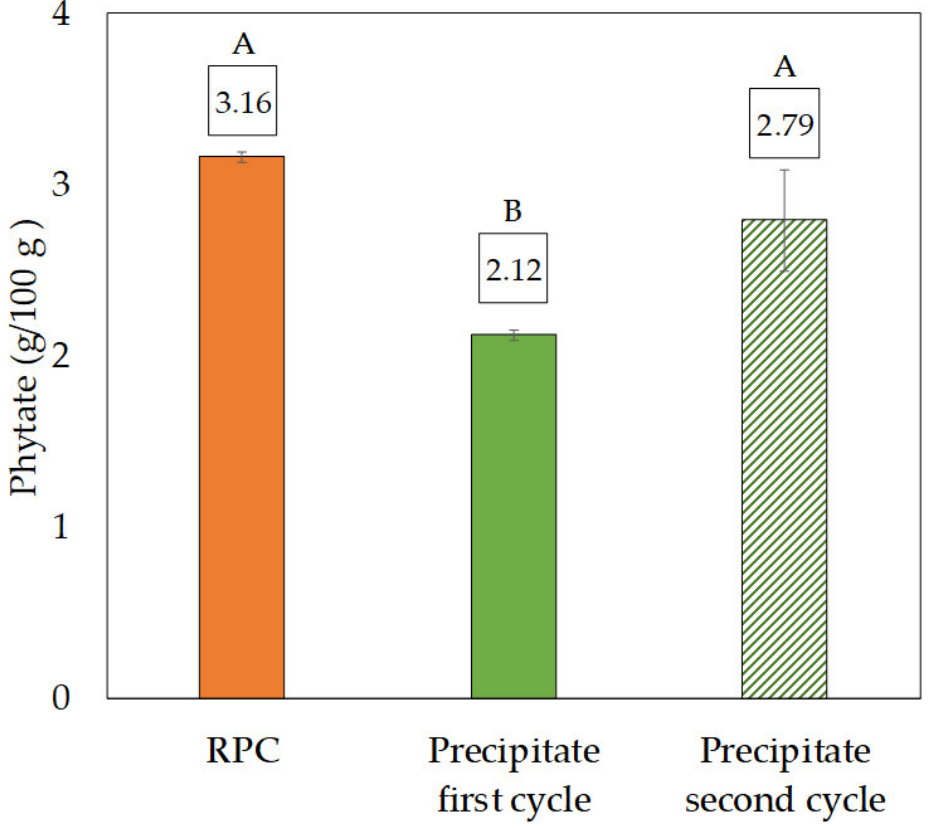
Figure 5. Phytate content (g/100 g on dry basis) in RPC (rapeseed press cake) and the precipitate after the first and second cycle. Different letters indicate significant differences, p ≤